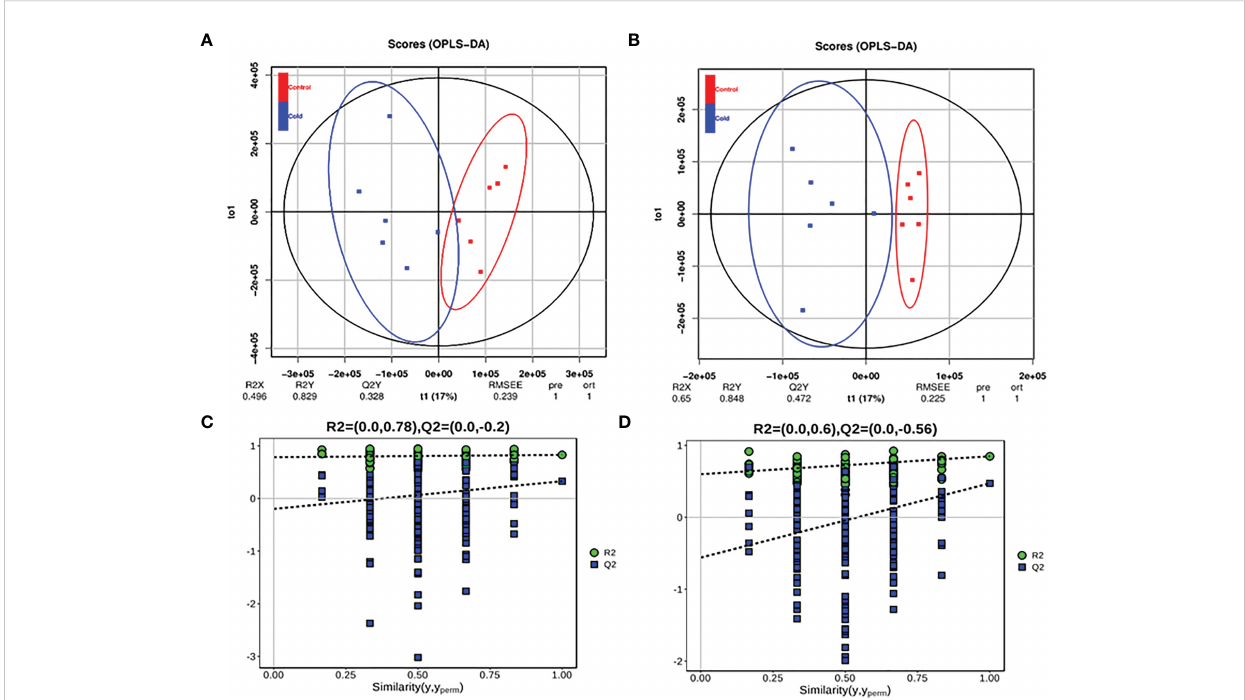
FIGURE 5 OPLS-DA model score diagram and OPLS-DA permutation test model of juvenile Trachinotus ovatus under low-temperature stress intestinal metabolites. (A) Positive ion mode, A blue spot in the OPLS-DA modes score diagram a Cold sample, and A red spot in the OPLS-DA modes score diagram a Control. (B) Negative ion mode. (C) Positive ion mode OPLS-DA permutation test model. (D) Negative ion